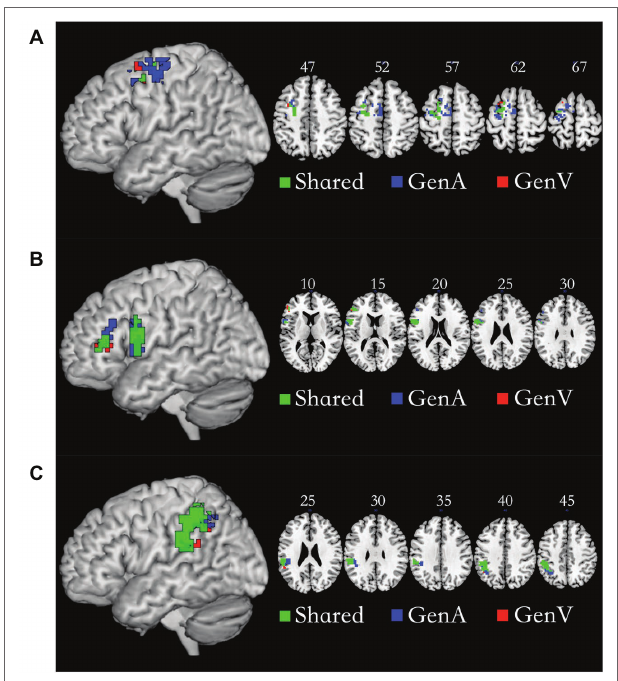
FIGURE 4 | Shared and specific sub-regions in the left premotor cortex (PMC; A ), the left inferior frontal gyrus (IFG; B ), and the left inferior parietal lobule (IPL; C ). (A) The GenA-PMC was located in the dorsal PMCd and the SMA. The GenV-PMC and Shared-PMC were located in the PMCd. (B) The GenA-IFG and Shared-IFG were located in Brodmann Area (BA) 44 and 45. The GenV-IFG was located in BA45. (C) GenA-IPL, GenV-IPL, and Shared IPL ROIs were all located in the left Supramarginal gyrus (BA40).